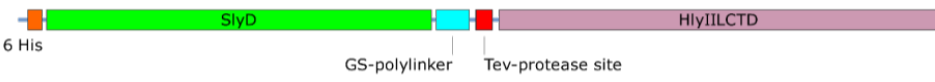
M, protein marker.